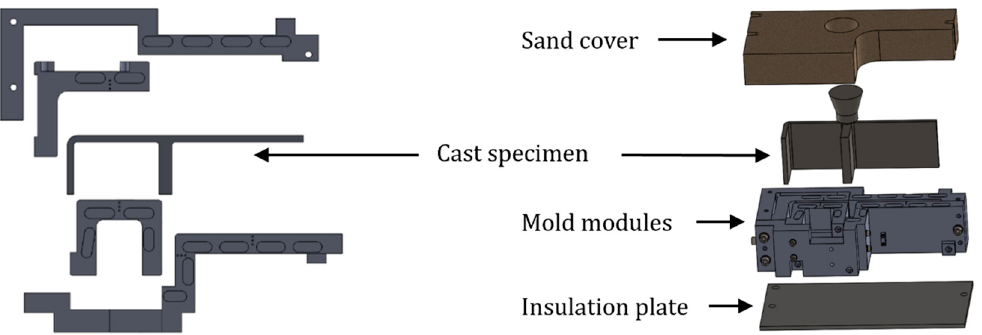
Figure 3. On the left, the modular mold design can be seen, which allows changes to geometry, mold material, or other by exchanging individual modules. The right side shows the cast part, the assembled mold modules, and the calcium silicate bottom plate serving as insulator and the sand cover with integrated inlet-feeder.